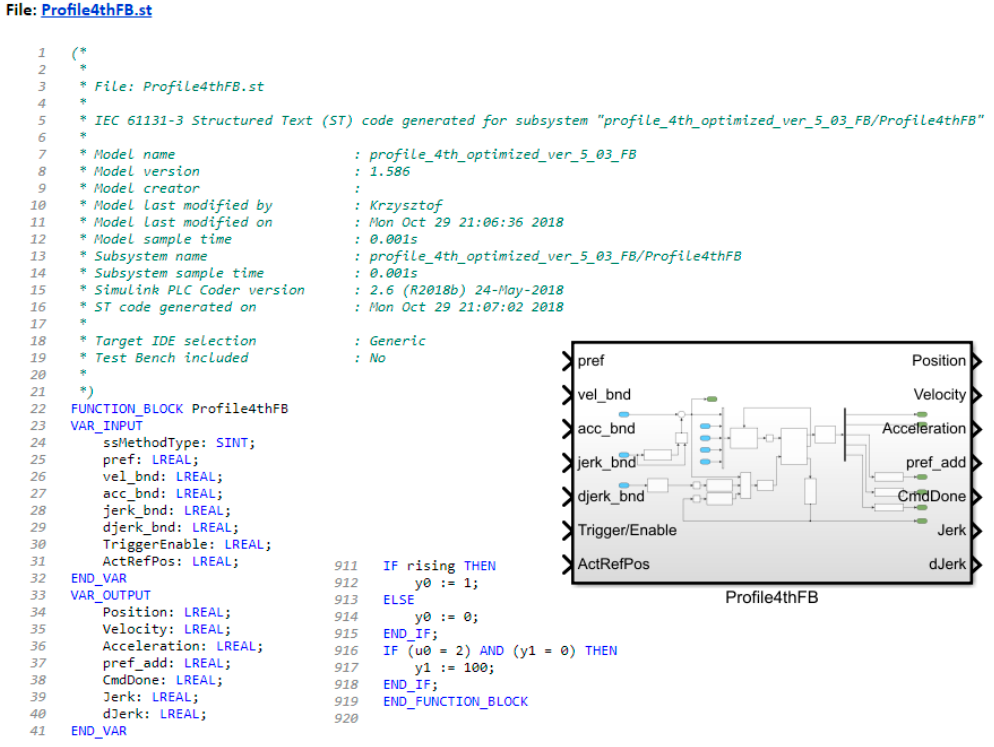
Figure 8. Code fragment generated via Simulink PLC Coder.